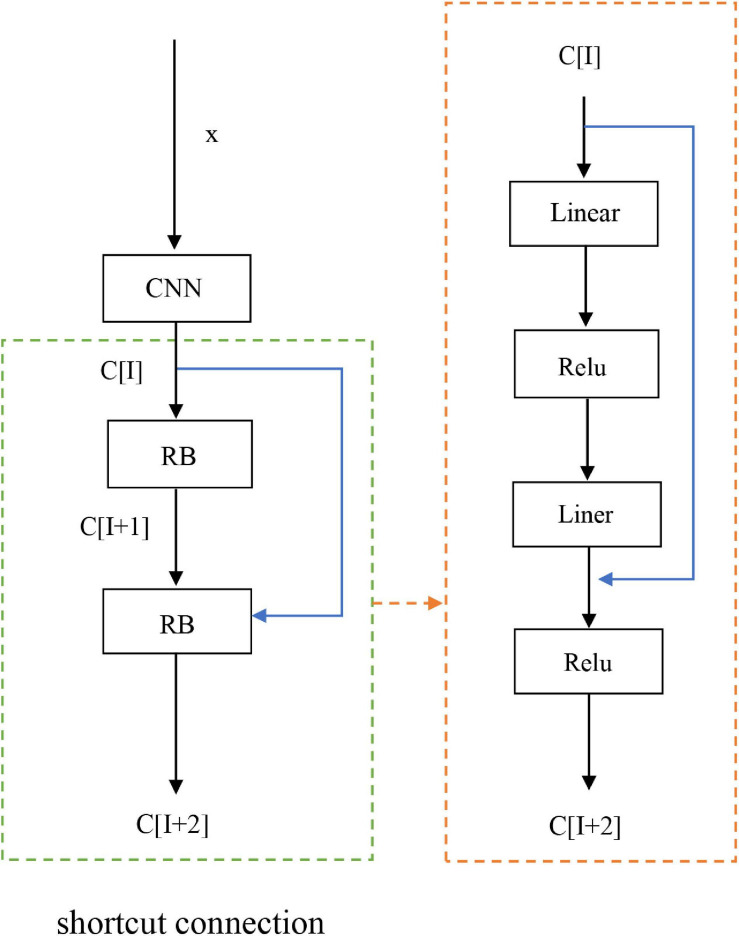
ResNet flowchart.